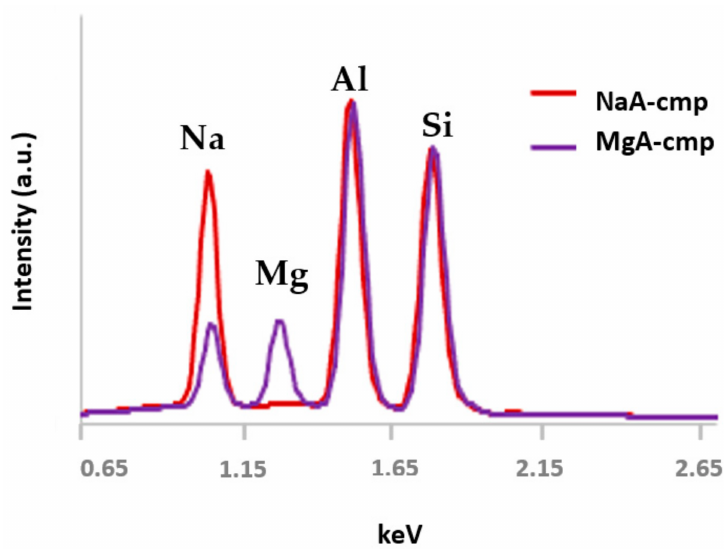
Figure A6. EDX spectra of NaA-cmp and MgA-cmp (side view) samples.